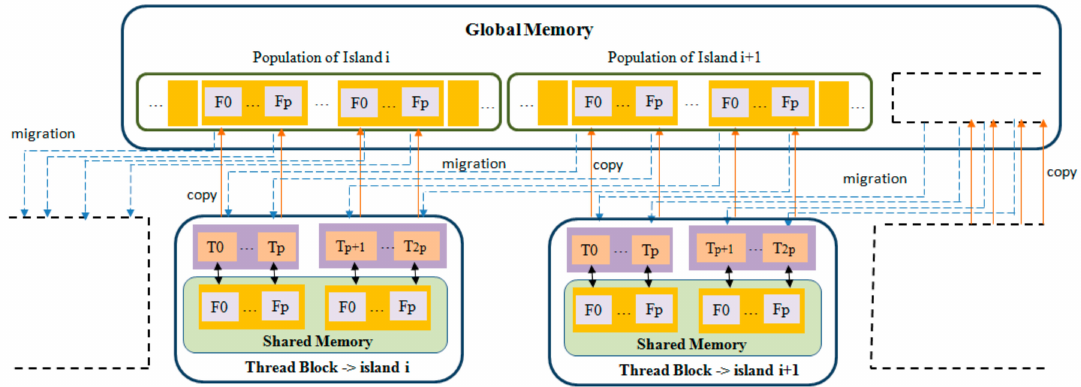
Figure 12. Migration between islands with one thread processing one gene